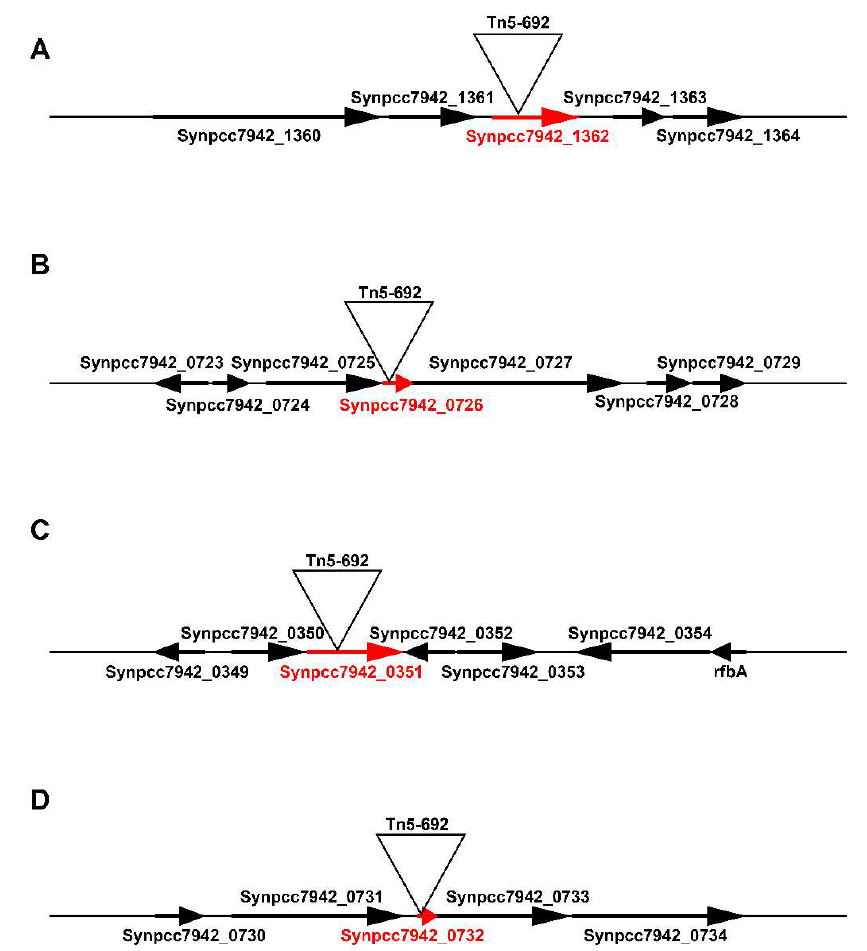
Figure 2. This scheme shows the transposon Tn5-692 localization in genomic regions of Synechococcus NR-mutants that were resistant to 2-nonanone. ( A ) Transposon insertion in Synpcc7942_1362 gene in NR401(Tn) mutant. ( B ) Transposon insertion in Synpcc7942_0726 gene in NR385(Tn) mutant. ( C ) Transposon insertion in Synpcc7942_0351 gene in NR365(Tn) mutant. ( D ) Transposon insertion in Synpcc7942_0732 gene in ΔNR359(Tn) mutant. 3.1.1. The Synpcc7942_1362 Gene was Inactivated by Tn5-692 in the Mutant NR401(Tn)